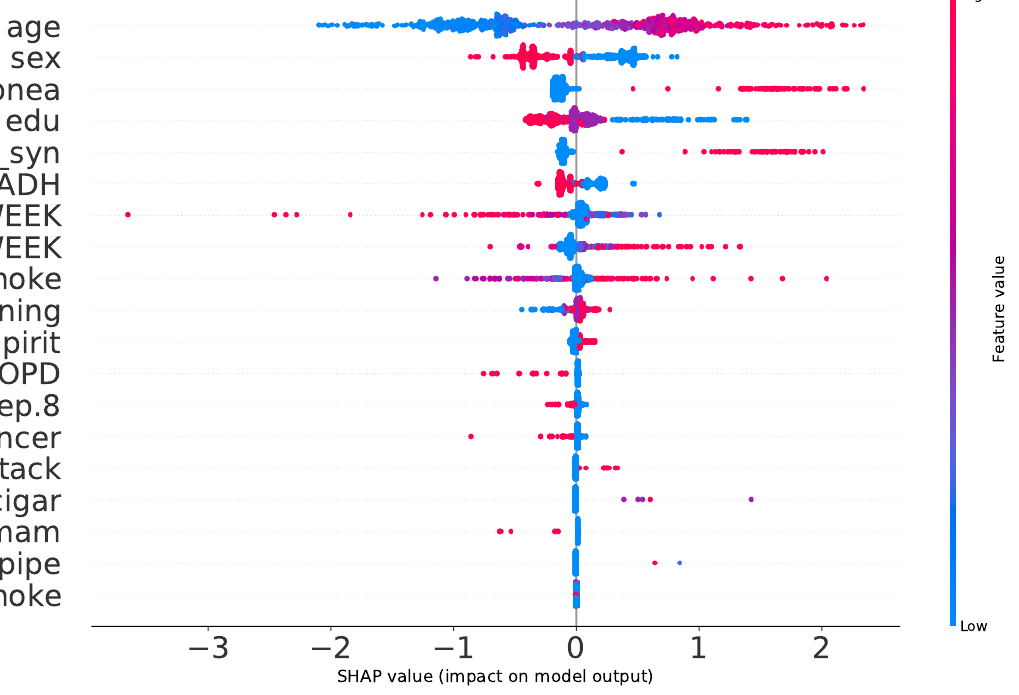
Figure 4. Impact of variables with SHAP, Gradient Boosting with Stud selection, with